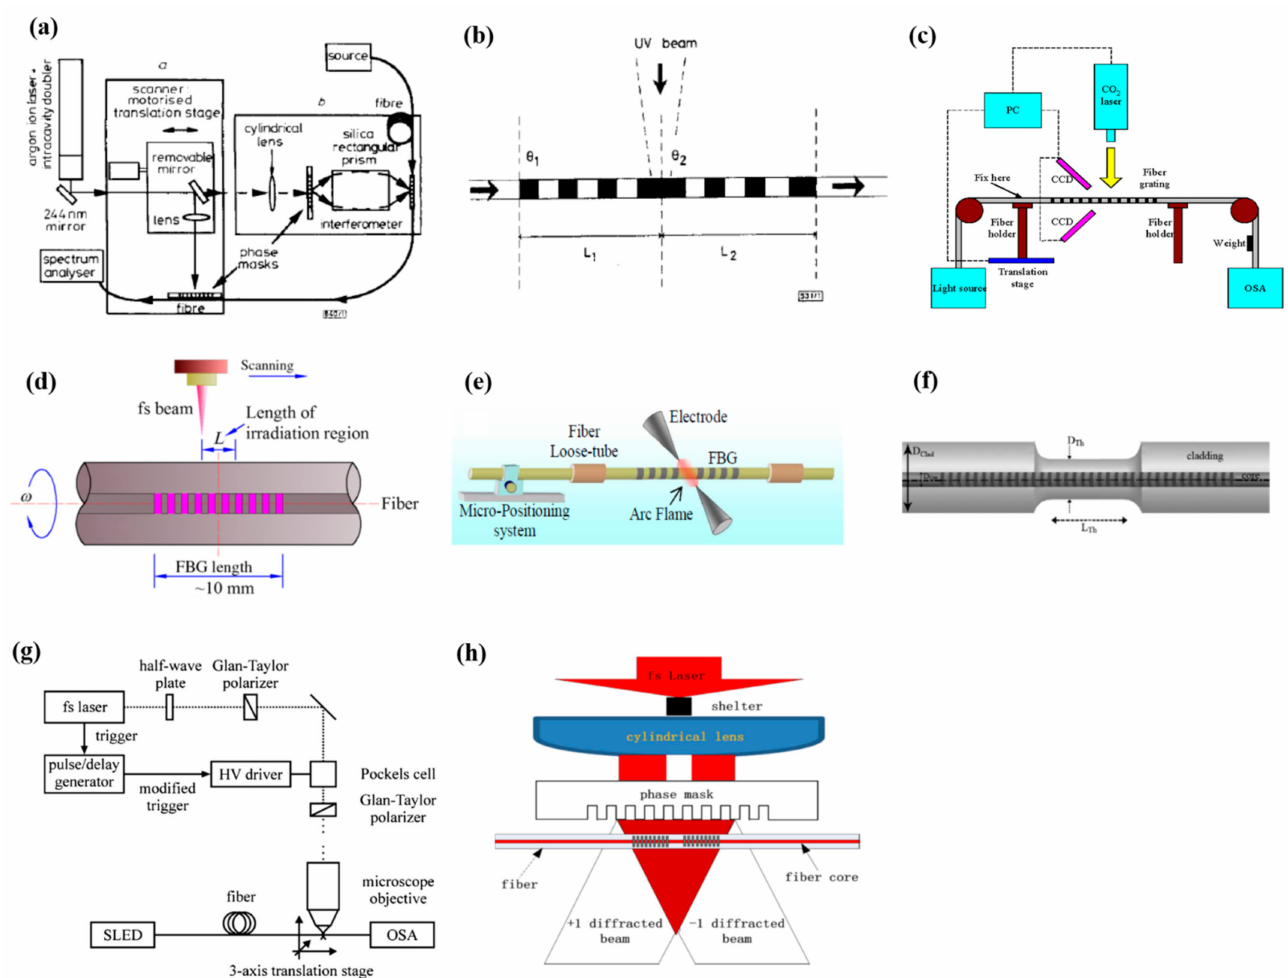
Figure 3. Fabrication methods for insertion of the permanent phase-shift into FBG. ( a ) Phase-shift phase mask method [9]. ( b ) The approach to erase the local part of the grating by using the UV light [10]. Post-processing techniques based on ( c ) the CO 2 laser irradiation [11], ( d ) femtosecond laser irradiation [12], and ( e ) electric arc discharge [13]. ( f ) Post-processing technique based on the chemical etching method. Adapted with permission from ref. [15]. ( g ) Point-by-point femtosecond laser writing technique [16]. ( h ) Shielded phase mask-based femtosecond laser writing technique. Adapted with permission from ref.